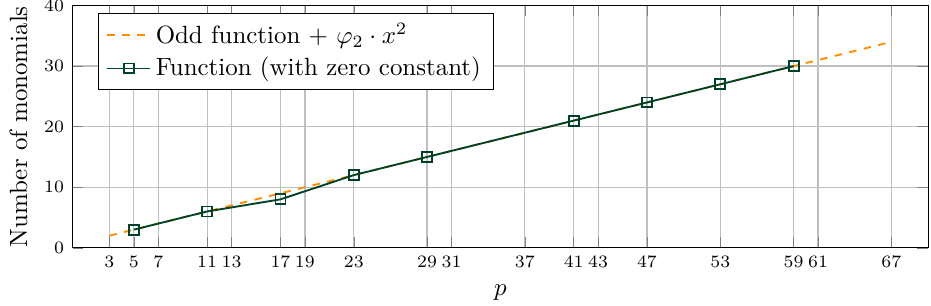
Figure 5: Comparison of the number of monomials for a generic function (with zero- constant) and for F ( x ) = ( − 3) ( x mod 2) · x 2 for several values of p .